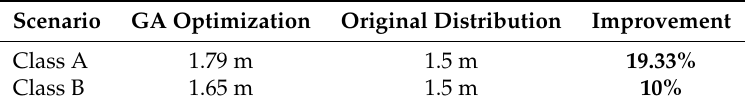
Table 5. Comparison of the mean table separation achieved between the GA optimized distribution and the initial mesh models.